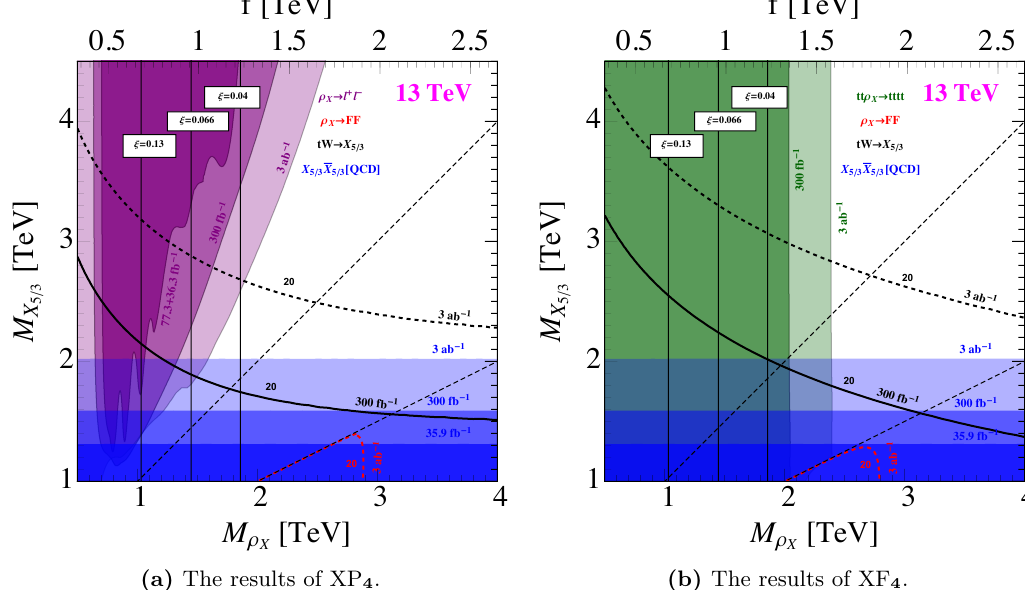
Figure 9. The current limits and prospective reach on model XP 4 (left plot) and model XF 4 (right plot). The parameters are chosen as eq. (3.3). The existing limits and projections from (cid:22) X X [QCD] [13] are plotted as shaded regions. The green regions come from t (cid:22) t(cid:26) 0 5 = 3 5 = 3 production, by the phenomenological study of ref. [102]. The purple regions represent the limit from the ‘ + ‘ (cid:0) search [12] and its extrapolations. The contours for N ( ‘ (cid:6) ‘ (cid:6) + jets) = 20 are drawn with solid (dashed) lines for 300 (3000) fb (cid:0) 1 , as a prospective reach for the (cid:26) 0 (cid:26) X ! FF ) and the tW ! X channels. See the text for more 5 = 3